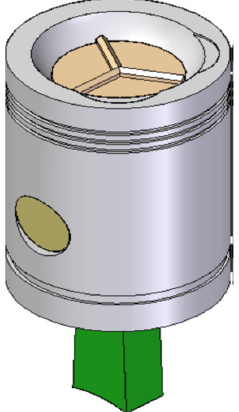
Figure 2. Modified piston [23].